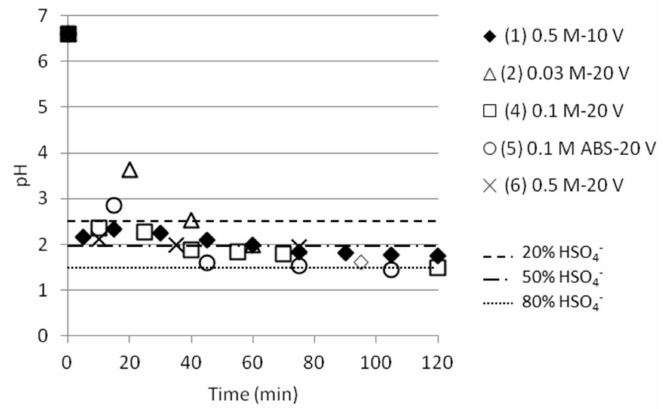
Figure 6. pH as function of time in the middle cell for the experiments presented in Figure 5. The lines give information about the presence of HSO 4 − in % versus SO 42 −